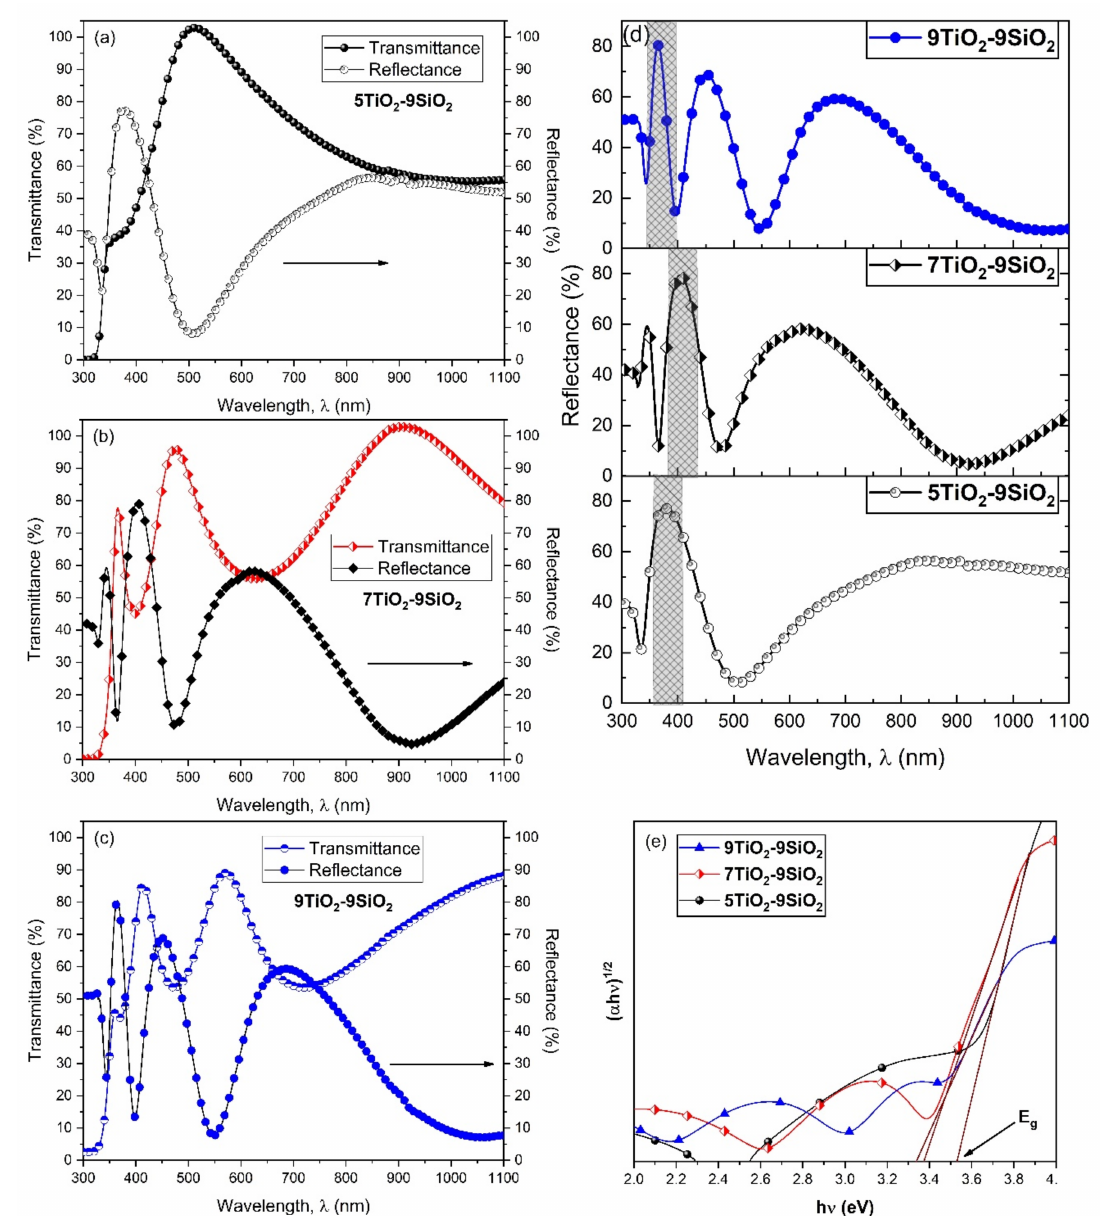
Figure 4. Determination of E g energy for TiO 2 -SiO 2 thin films. ( a – c ) Spectral dependence of T( λ ) and R( λ ) coefficients, ( d ) UV–Visible reflectance spectra of TiO 2 -SiO 2 thin films, ( e ) E g determined by optical method using ( α h ν ) 1/2 vs. h ν plots of thin films deposited with different numbers of TiO 2 -SiO 2